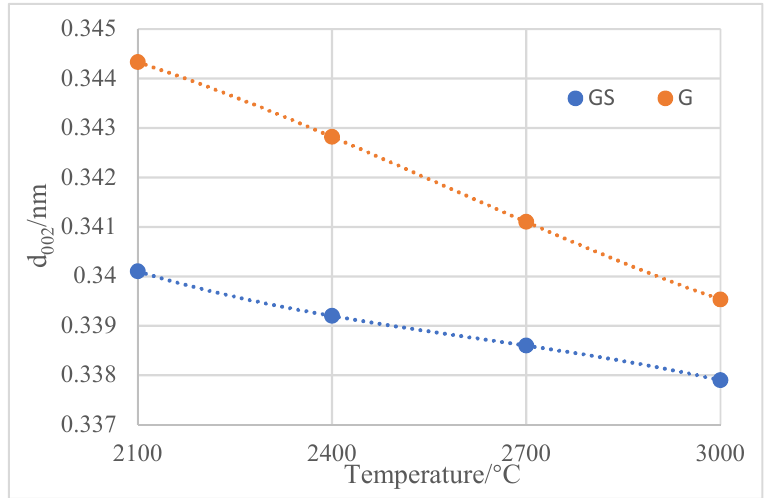
Figure 6. d 002 of samples with changes in temperature.